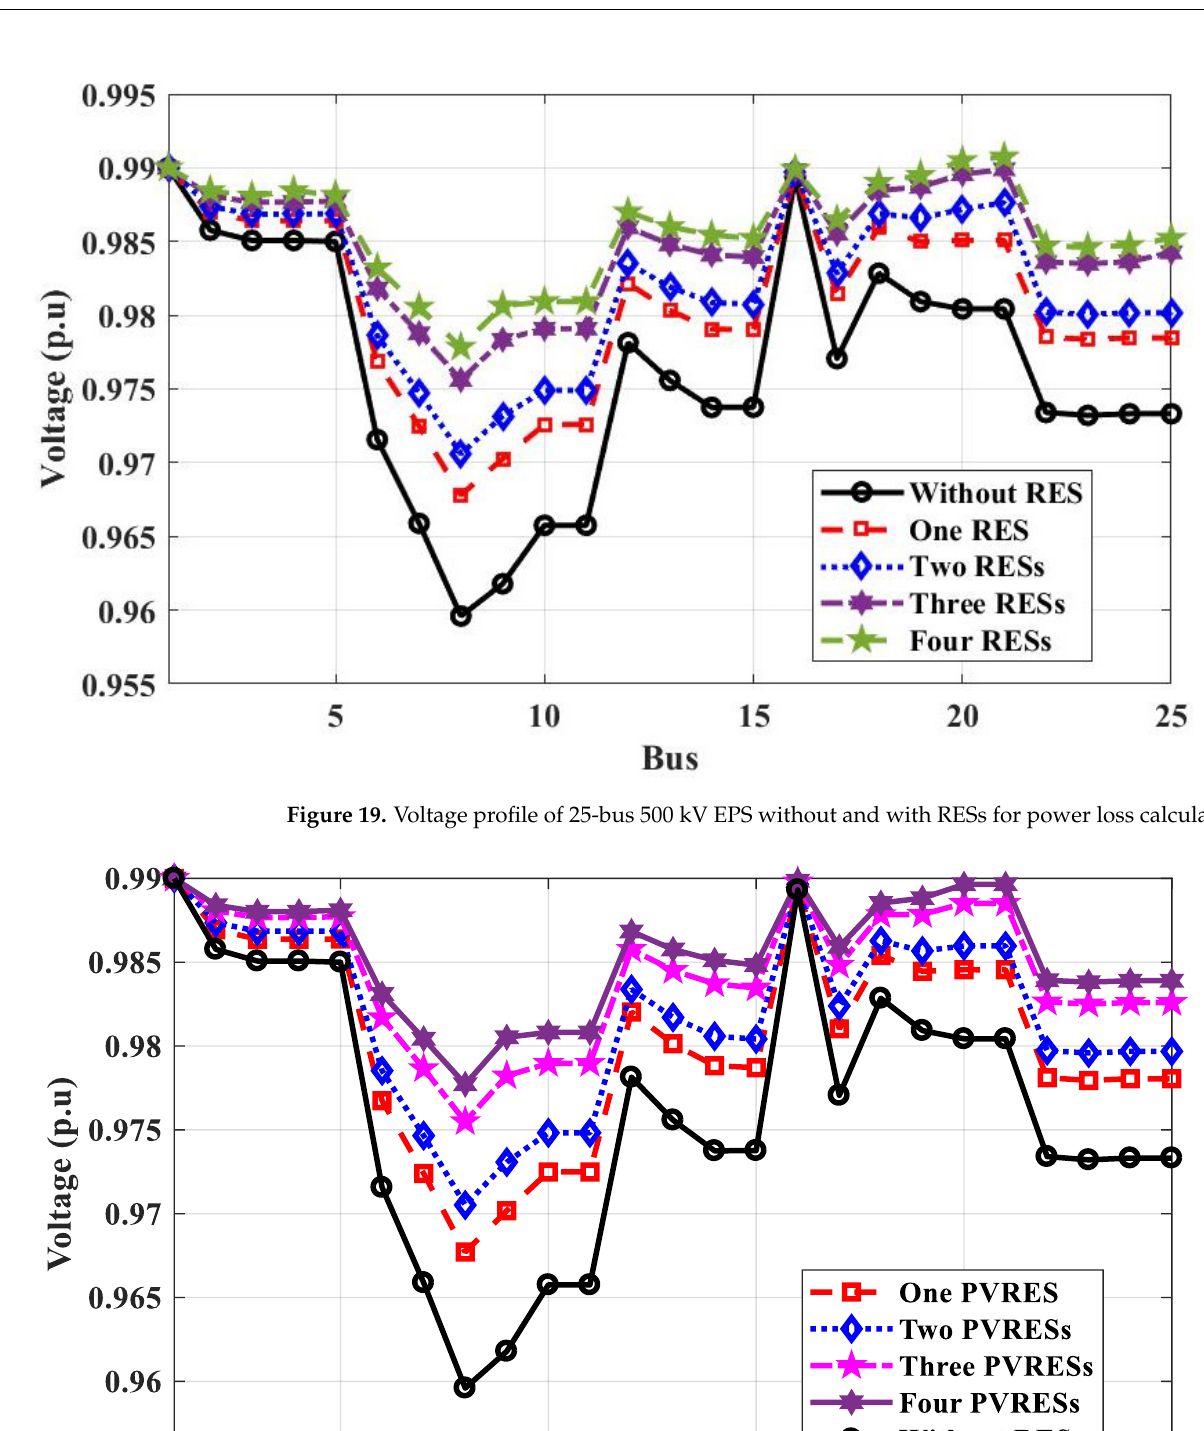
Figure 21. Voltage profile of 25-bus 500 kV EPS without and with wind systems for annual energy loss calculation. Table 5 shows that the optimal locations of RESs are 18, 21, 25, and 4 using the GA method, compared to 2, 16, 5, and 3 using the proposed technique based on power calcu- lation. The power loss of the system calculated by the GA method is less than that calcu- lated using the proposed method. The minimum voltage has been improved to 0.9778 p.u at bus No. 8 for the proposed and GA methods, as shown in Figure 19. The optimal loca- tions of RESs of PV systems or wind farms connected to 25-bus 500 kV EPS based on en- ergy calculation are different from the optimal locations of PV systems and wind farms based on power calculation due to the value of irradiation and wind speed. The optimal